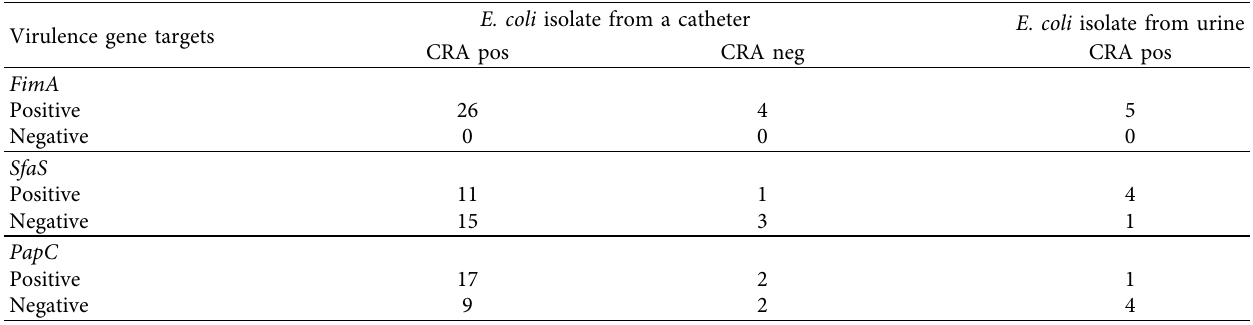
Table 7: Proportion of biofilm-forming E. coli virulence